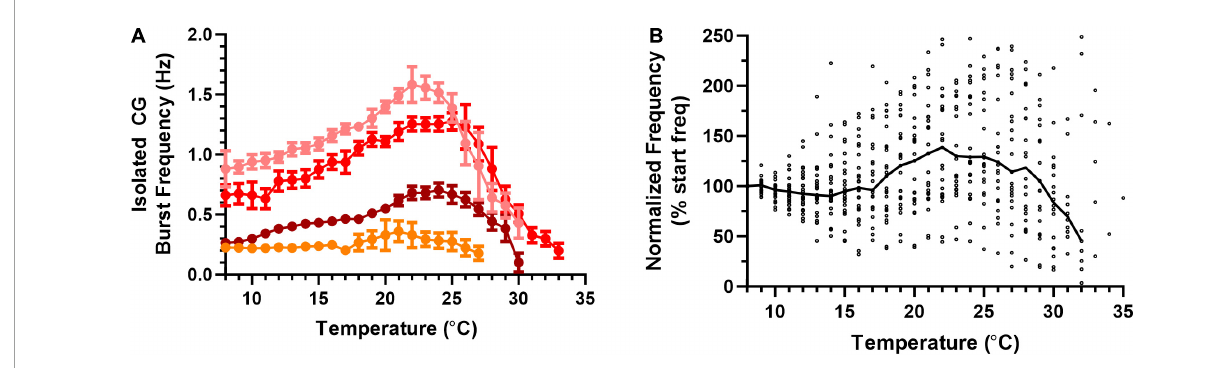
FIGURE5 Frequency of bursts in an isolated cardiac ganglion increases, then decreases in response to an increasing temperature ramp. Values show data averaged in 1 ◦ C bins, with the data plotted at the center of each bin. (A) Plot of CG burst frequency as a function of temperature for four example preparations as temperature was increased from 8 ◦ C to crash temperature. Note that there no longer exists an inflection point in burst frequency at 18 ◦ C as was the case for contraction frequency. Although three of the preparations show clear increases followed by decreases in frequency, the change from increase to decrease occurred at different temperatures in each preparation. All data points show the mean ± SD for burst frequency at each temperature step. (B) Plot of normalized burst frequency as a function of temperature, with the burst frequency of each preparation at each temperature step normalized to the burst frequency at 8 ◦ C ( N = 25 until the first preparation crashes at 20 ◦ C; N decreases from that temperature on, until N = 1 at 35 ◦ C). The solid back line connects median normalized burst frequency at each temperature step. Medians are omitted when N ≤